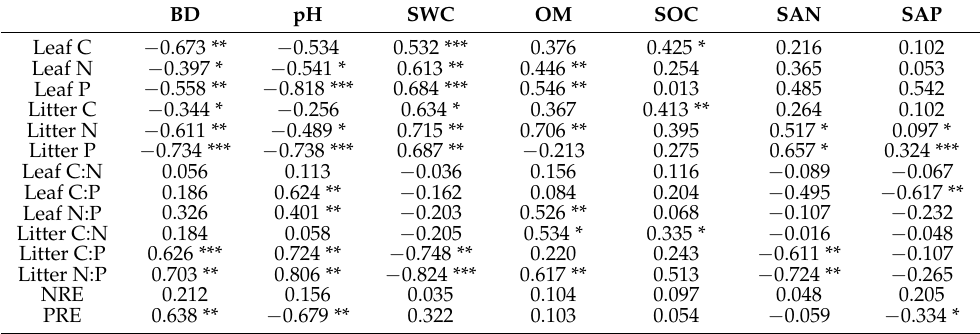
Table 4. The correlation coefficients between nutrient content, soil properties, stoichiometric ratios in leaves and litter, and NuRE after thinning. *** p < 0.001; ** p < 0.01; * p < 0.05. BD pH SWC OM SOC